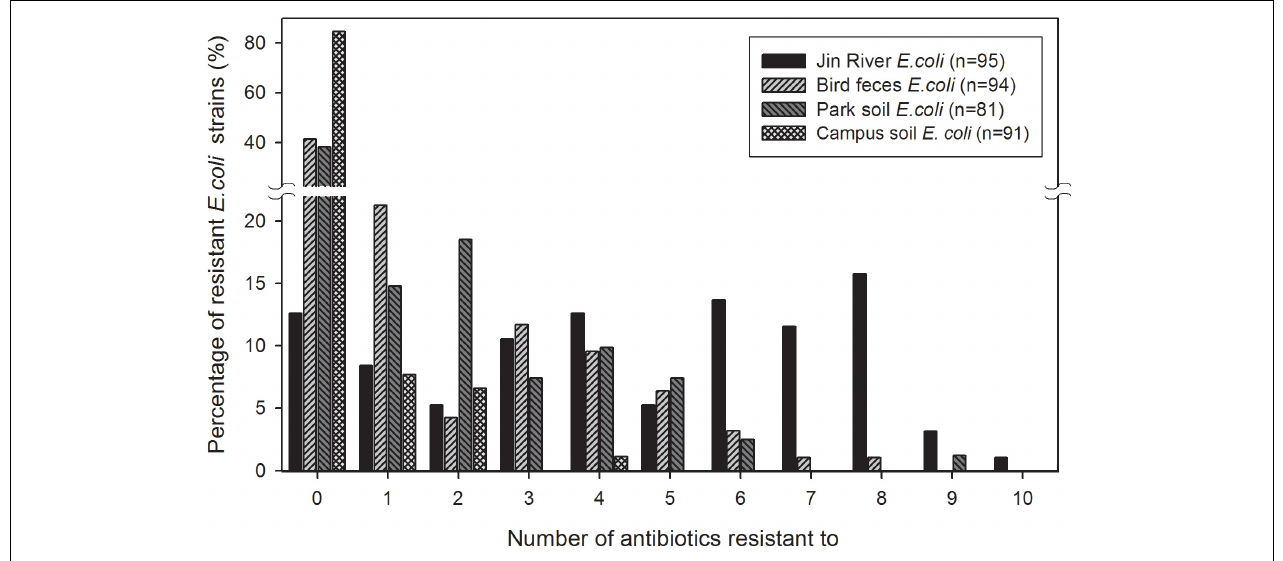
FIGURE 3 | Multidrug resistance (MDR) among the E. coli isolates from different environmental samples. The E. coli isolates of Jin River water gave the highest level of MDR. Most of the campus soil isolates (92.3%) showed no MDR. The E. coli isolated from egret feces and park soil exhibited similar level of MDR.